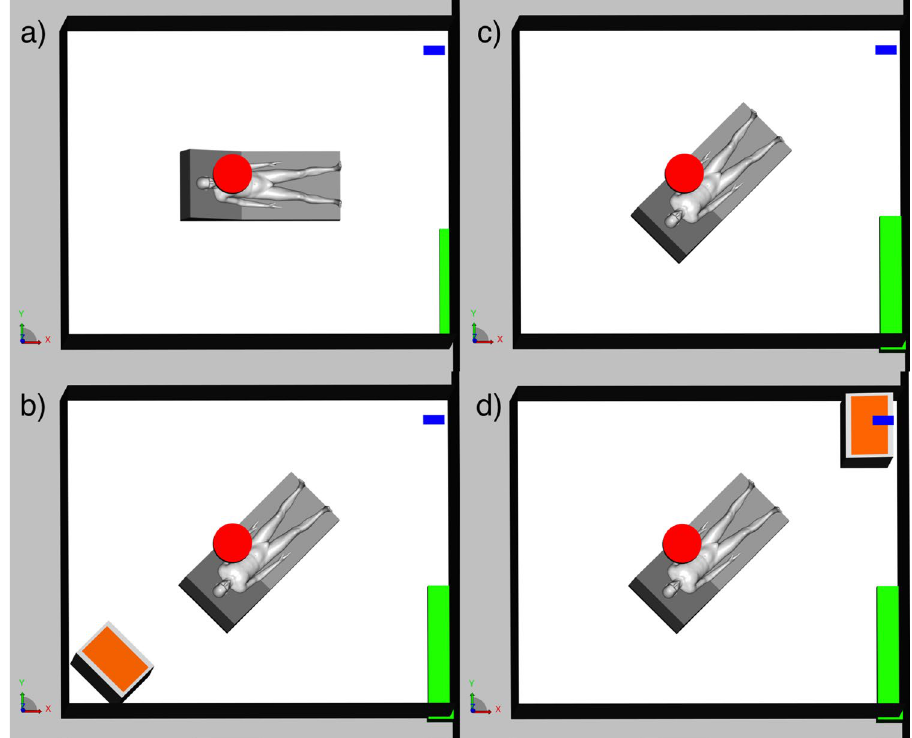
Figure 1. Room configuration for the 4 scenarios that were modelled: ( a ) Baseline configuration; ( c ) 45° bed orientation configuration; ( b ) Plasmair + 45° bed orientation in configuration 1; ( d ) Plasmair + 45°